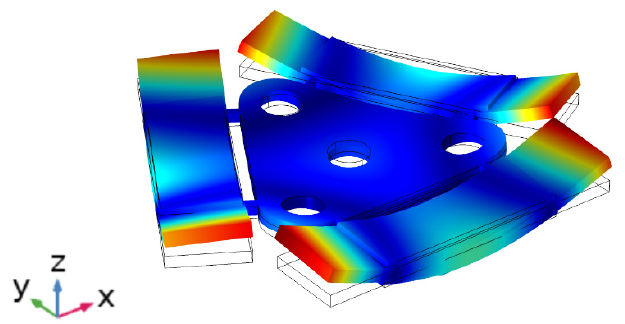
Figure 6. Modal shape of platform obtained at 23.54 kHz.